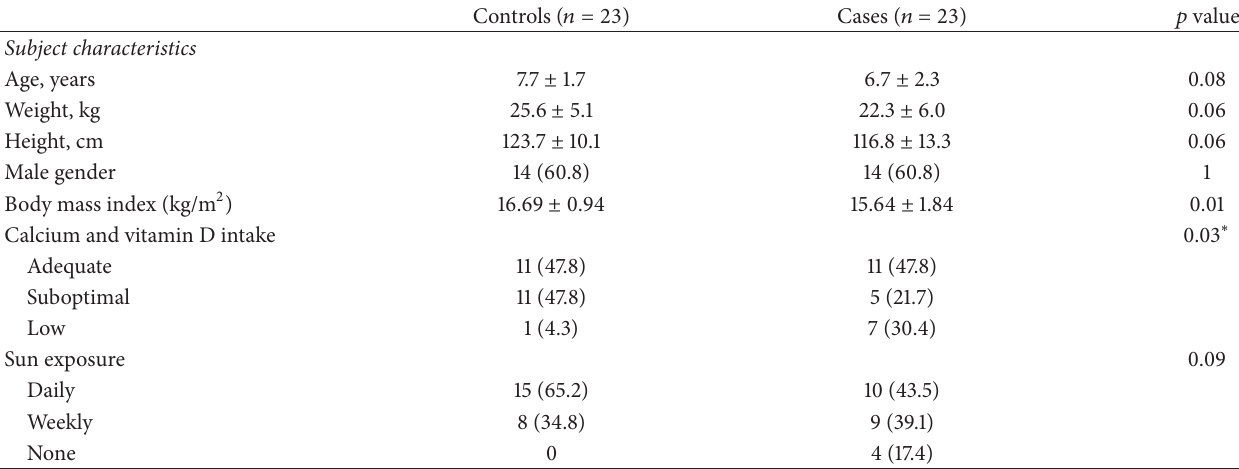
Table 2: Subject characteristics and calcium and vitamin D